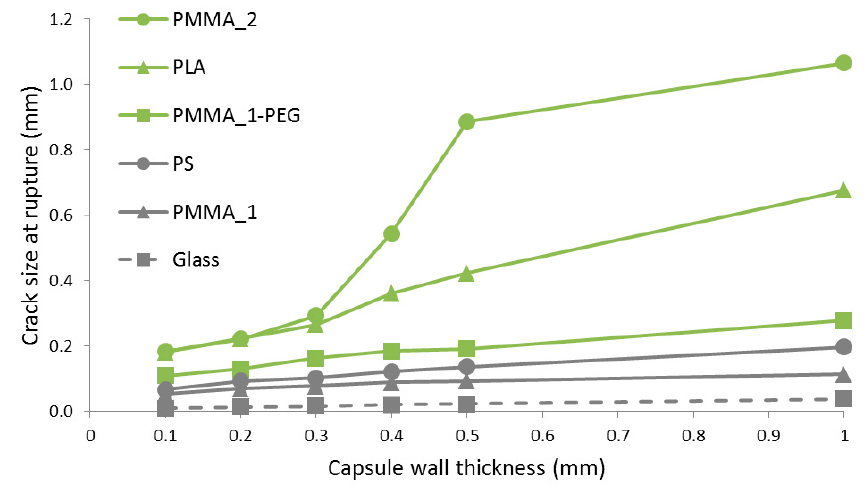
Figure 8. Model output for tubular capsules with an external diameter of 5 mm embedded in a mortar matrix under tensile stress.